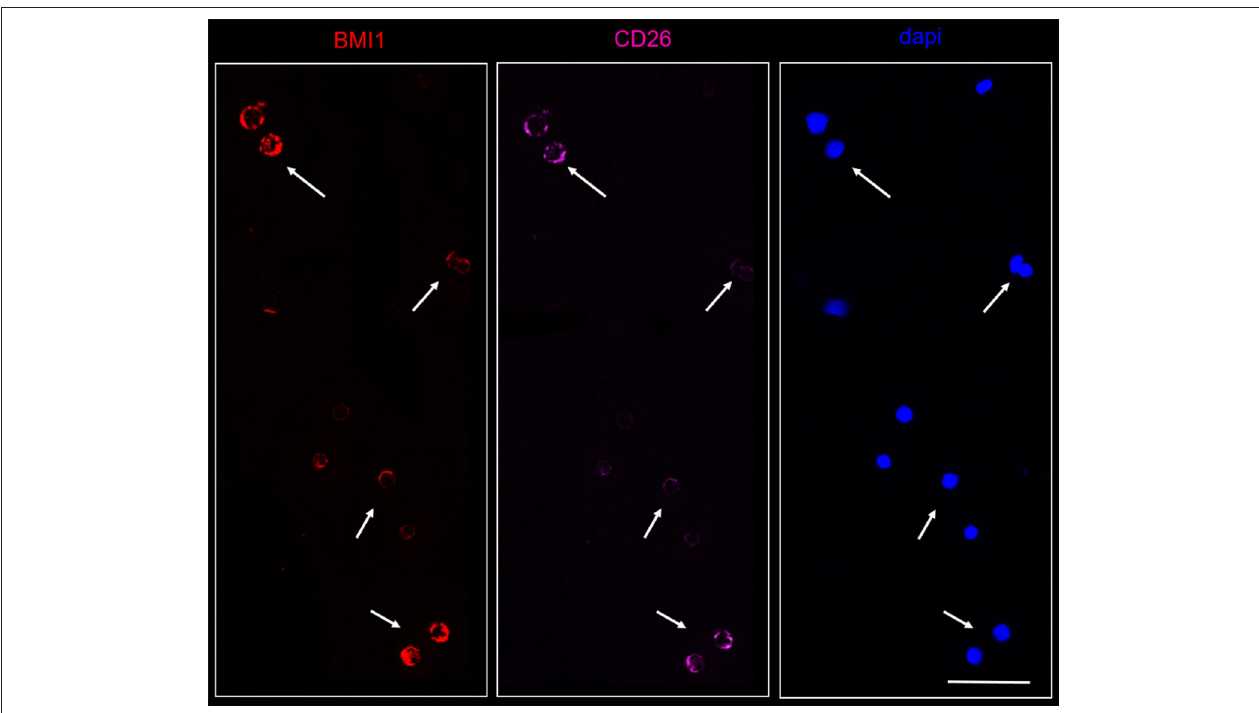
FIGURE 6 | Confocal laser scanning microscopy: representative images of a bone marrow smear from one of the 9 CML patients enrolled into the study with a high representation of CD26 + cells. Bidimensional images of the maximum intensity projection. Scale bars 50 µ m. From the right to the left: in blue, the nuclei; in pink, the CD26 + cells; in red, the BMI1 + cells. Cluster of cells marked by the arrows co-expressed CD26 and BMI1